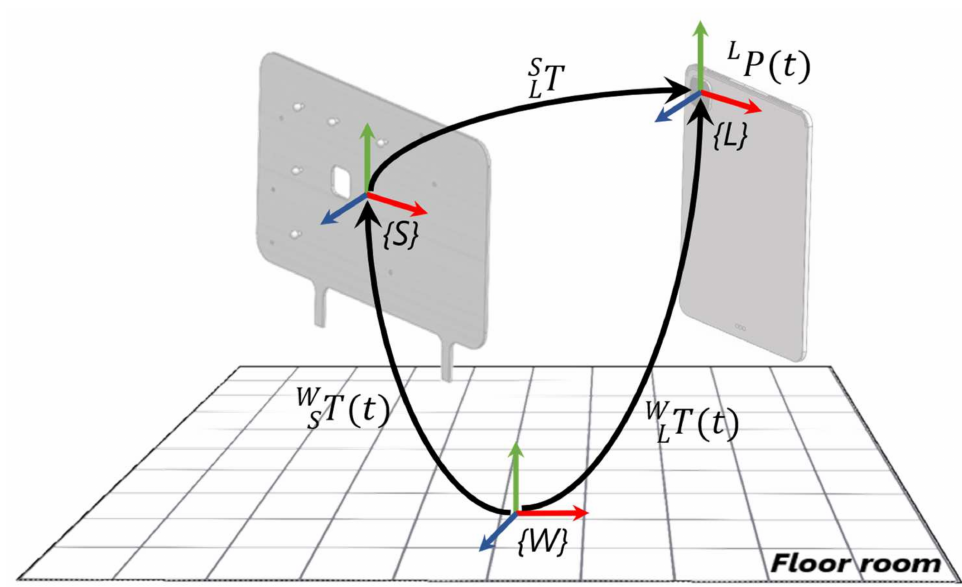
Figure 2. Mathematical model representation for comparing tracking